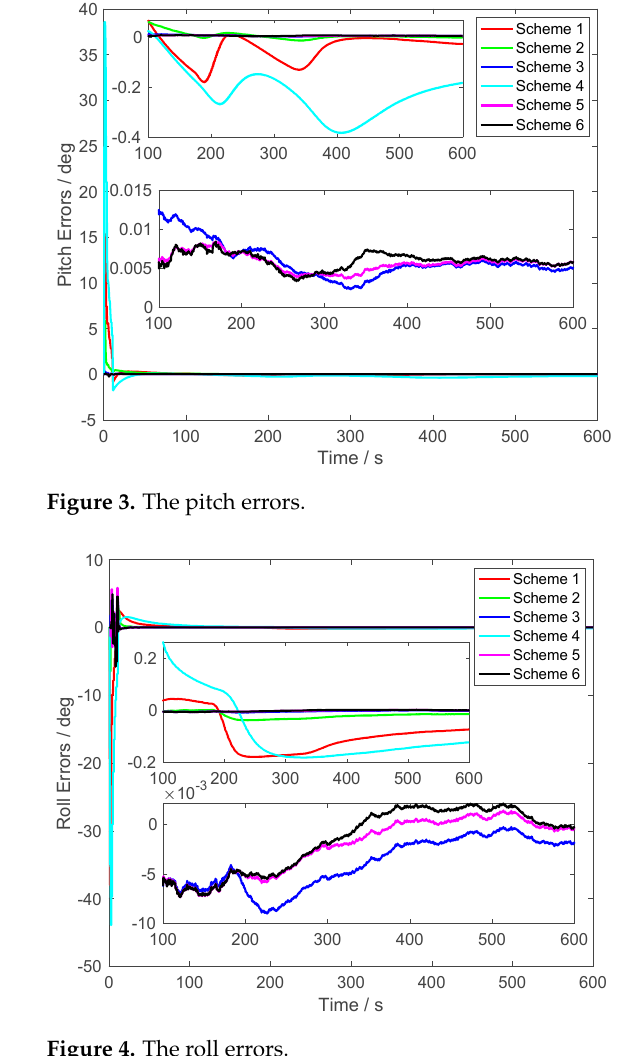
Figure 4. The roll errors.